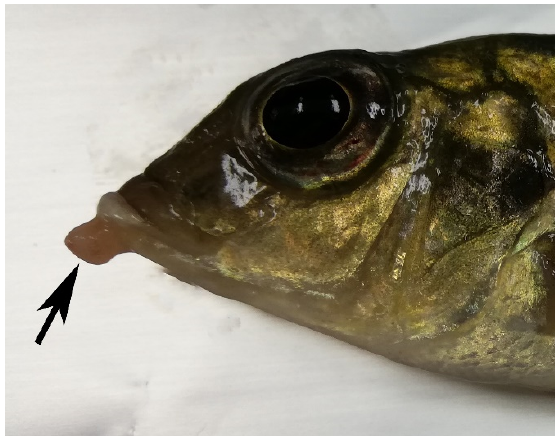
Figure 1. Case 7. Cichlid fish. M. guentheri . Region of the mouth, showing a pinkish nodule bulging from the oral mucosa (black arrow).